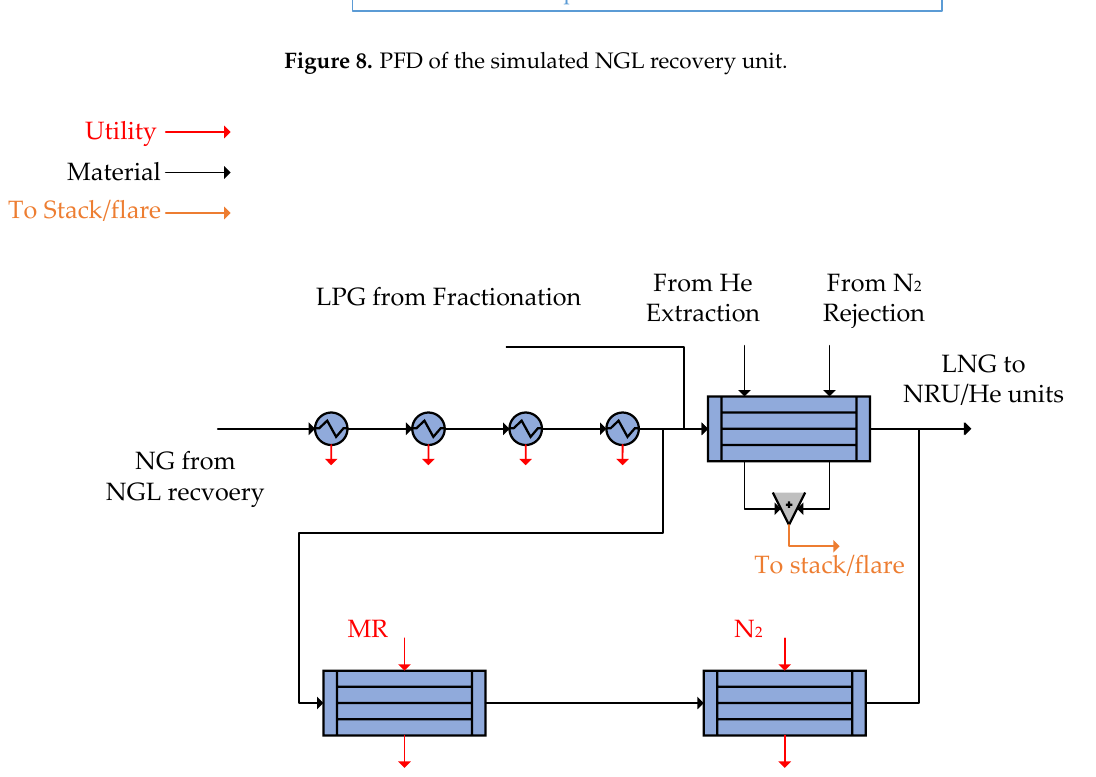
Figure 9. PFD of the simulated liquefaction unit.